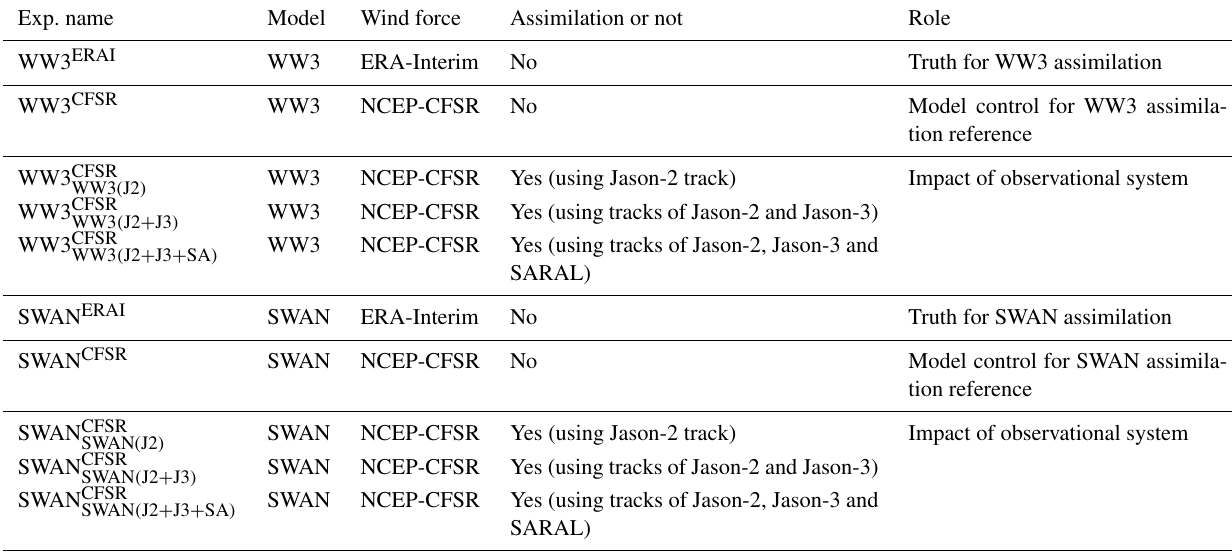
Table 1. List of perfect model twin